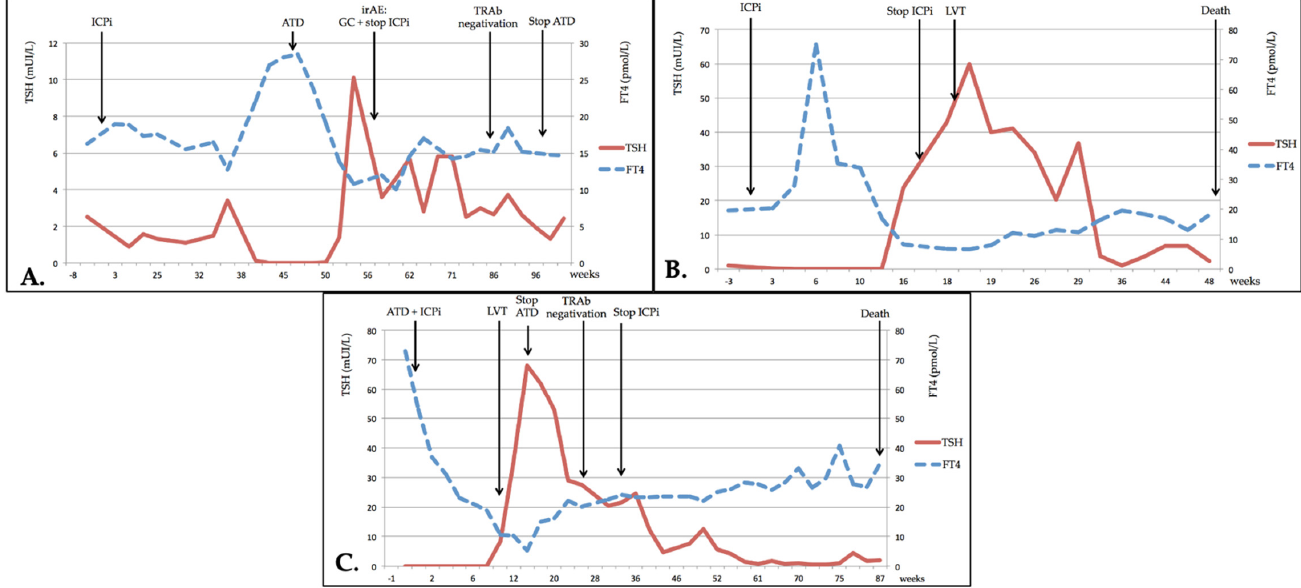
Figure 2. Evolution of thyroid dysfunction. ( A ) Patient no. 1; ( B ) Patient no. 3; ( C ) Patient no. 6. TSH: thyroid stimulating hormone; FT4: free thyroxine; ICPi: immune checkpoint inhibitor; ATD: antithyroid drug therapy; irAE: immune-related adverse event; GC: glucocorticoids; TRAb: TSH-receptor autoantibodies; LVT: levothyroxine.